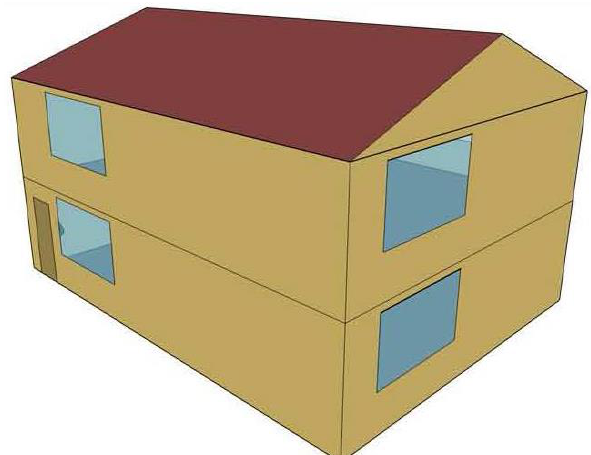
Figure 2. Rendering of the detached home model used in this study.